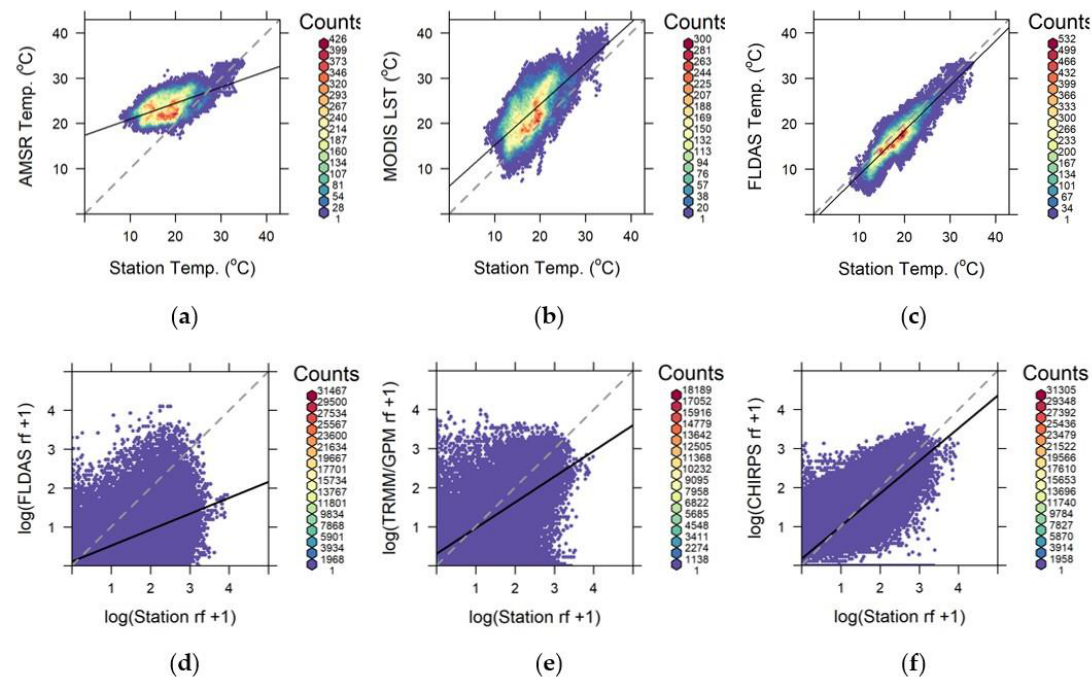
Figure 8. Binned scatter plots of temperature ( a – c ) and rainfall ( d – f ) from satellite / interpolated and 3.3. Accuracy Statistics station datasets. The light gray diagonal dashed lines are 1:1 lines, while the solid-black lines are fitted linear regression lines. Note the color variation of the hexagons. Each hexagon holds one or more number of data points, with red-highest and purple-lowest number of points. Note also the convergence / divergence of the linear regression line from the 1:1 diagonal